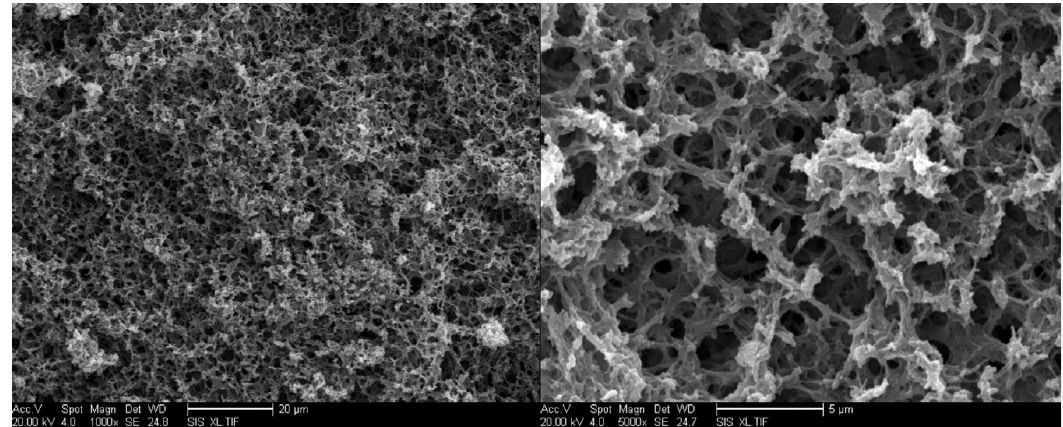
Figure 1. SEM images of porous polyurea monolith at centrifugal speed of 3000 rpm in low and high magnification at 1000× and 5000× magnification. From reference [16].